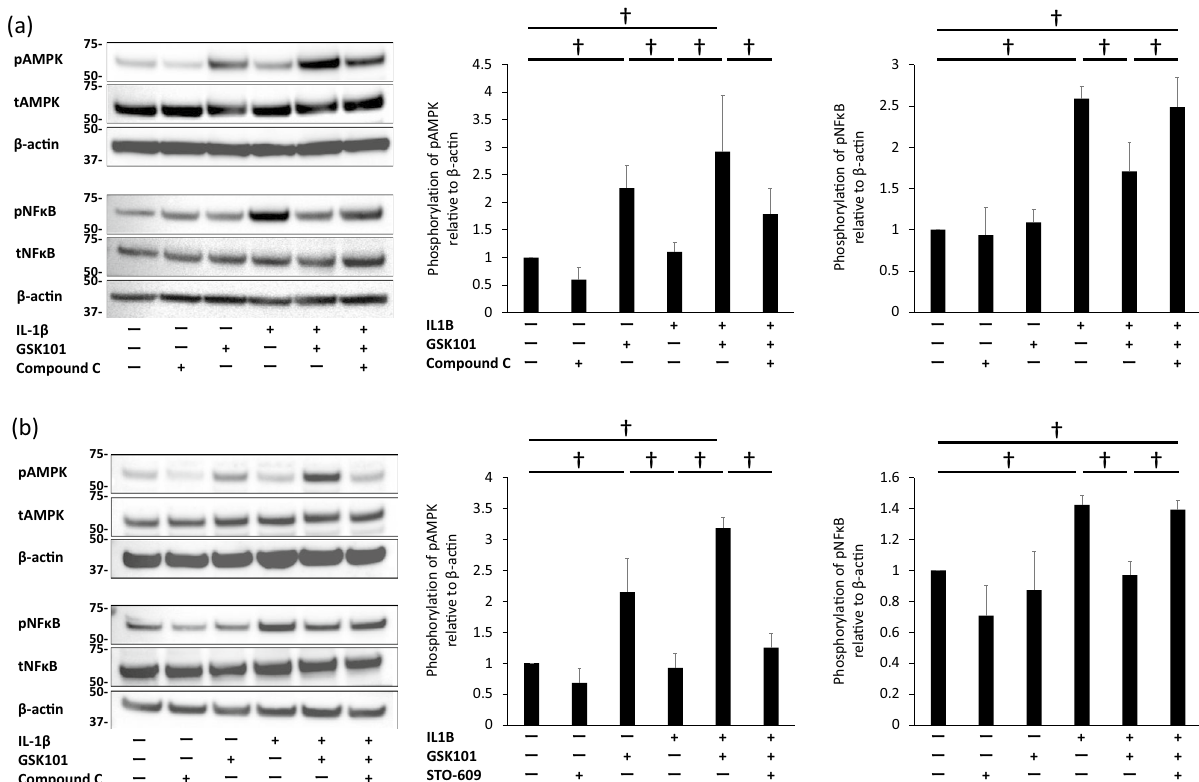
Figure 3. Inhibition of NF-κB phosphorylation by activation of the CaMKK/AMPK pathway. Levels of pAMPK and pNF-κB in BACs treated with ( a ) IL-1β, GSK101, and Compound C (25 µM), and ( b ) IL-1β, GSK101, and STO-609 (5 µM) for 30 min, as assessed by Western blot. Experiments were repeated three times. Each group of pNFκB, tNFκB and β-actin was derived from the same membrane. Each group of pAMPK, tAMPK and β-actin was derived from the same membrane. The membrane associated with NFκB and the membrane associated with AMPK were different while their protein samples were the same. ( a ), ( b ) showed that stimulation with IL-1β